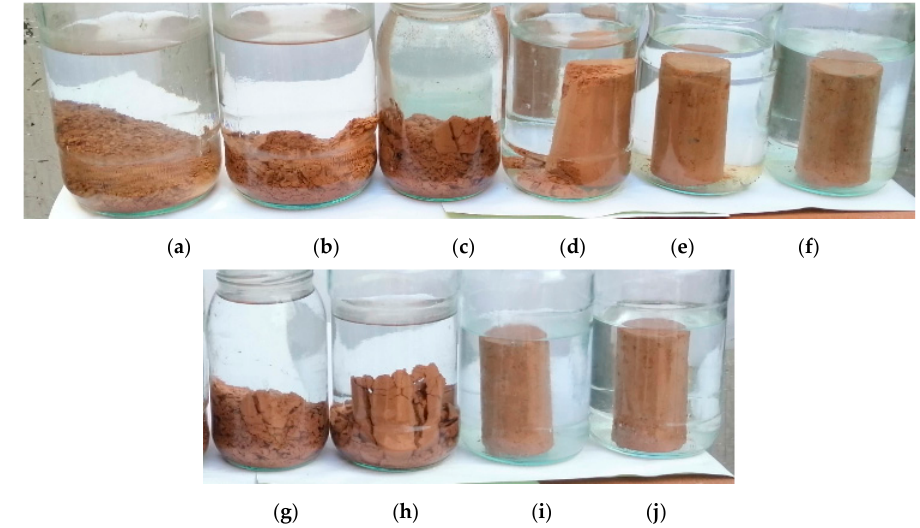
Figure 8. Durability of stabilized 28 day cured stabilized specimens under water after 7 days: ( a ) Marl; ( b ) Marl-3C; ( c ) Marl-3C-0.1NS; ( d ) Marl-3C-0.5NS; ( e ) Marl-3C-1.0NS; ( f ) Marl-3C-1.5NS; ( g ) Marl-3C-0.1NA; ( h ) Marl-3C-0.5NA; ( i ) Marl-3C-1.0NA; ( j ) Marl-3C-1.5NA.